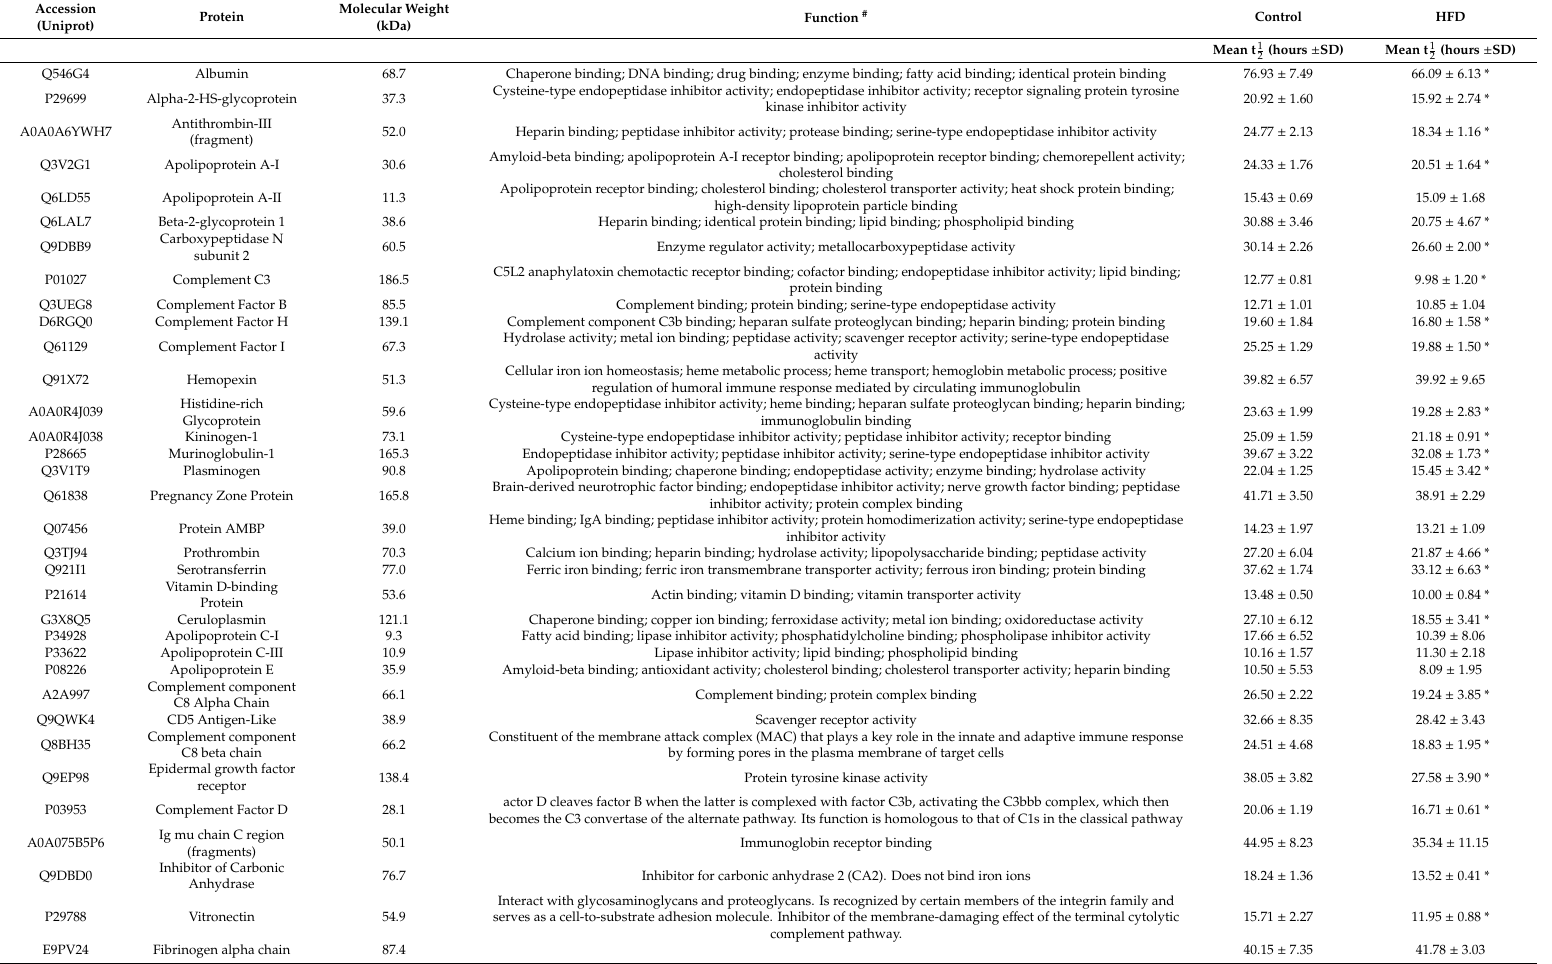
HFD: High-Fat Diet; HDL: high-density lipoprotein. # These functions were curated from the UNIPROT database. * p < 0.05 vs.